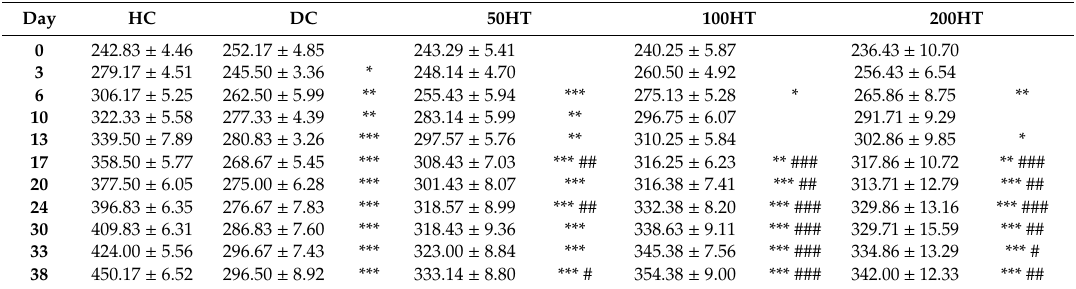
Table 2. E ff ect of horsetail on body weight. The *, ** and *** indicates significant di ff erence from the HC group ( p < 0.05, p < 0.01, and p < 0.001, respectively). The #, ##, and ### indicates significant di ff erence from the DC group ( p < 0.05, p < 0.01, and p < 0.001, respectively).